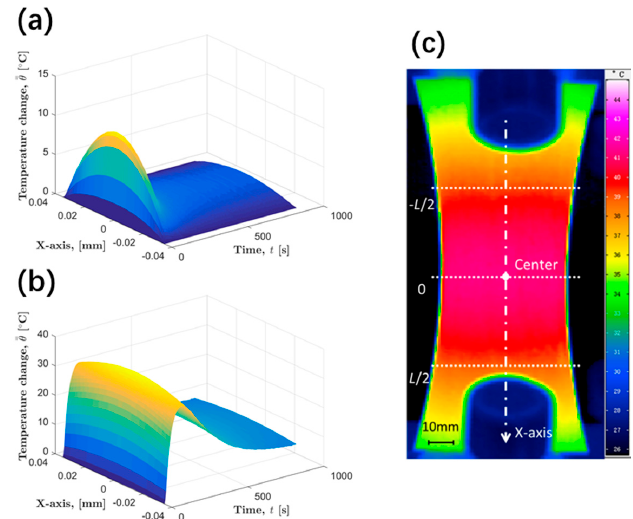
Figure 5. Example of specimen temperature change that has been modeled, ( a ) after processing, ( b ) before processing, ( c ) two set virtual